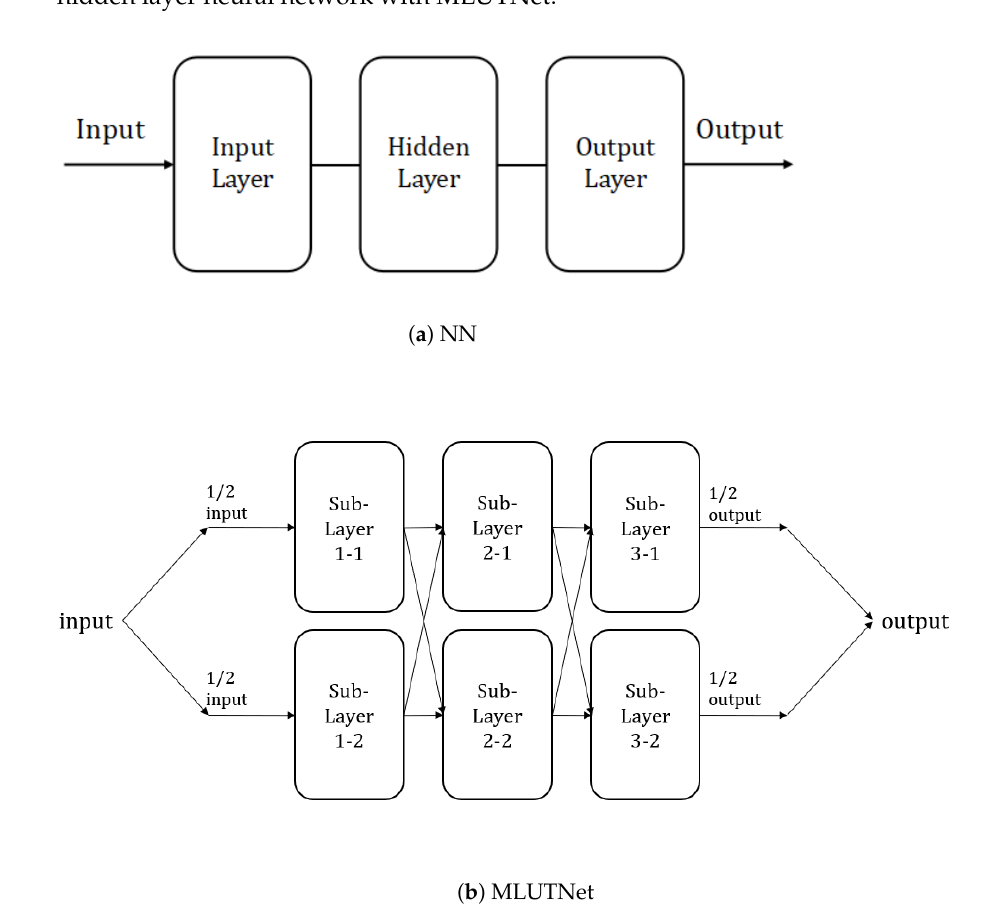
Figure 2. One NN and